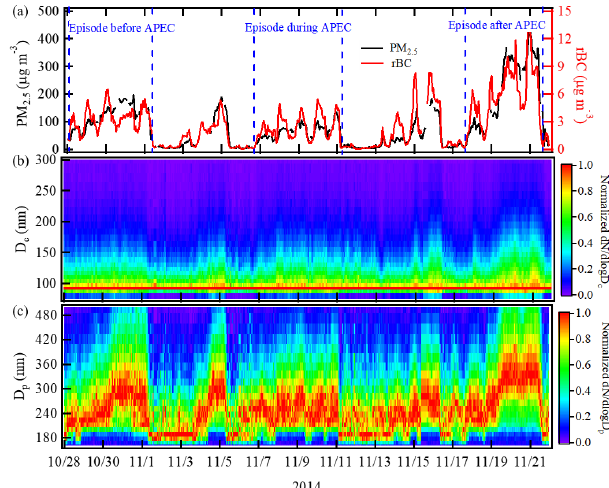
Figure 1. Time series of (a) the mass concentrations of PM 2 . 5 and rBC and the number size distribution of (b) rBC cores ( D c ) and (c) whole BC-containing particles ( D p )